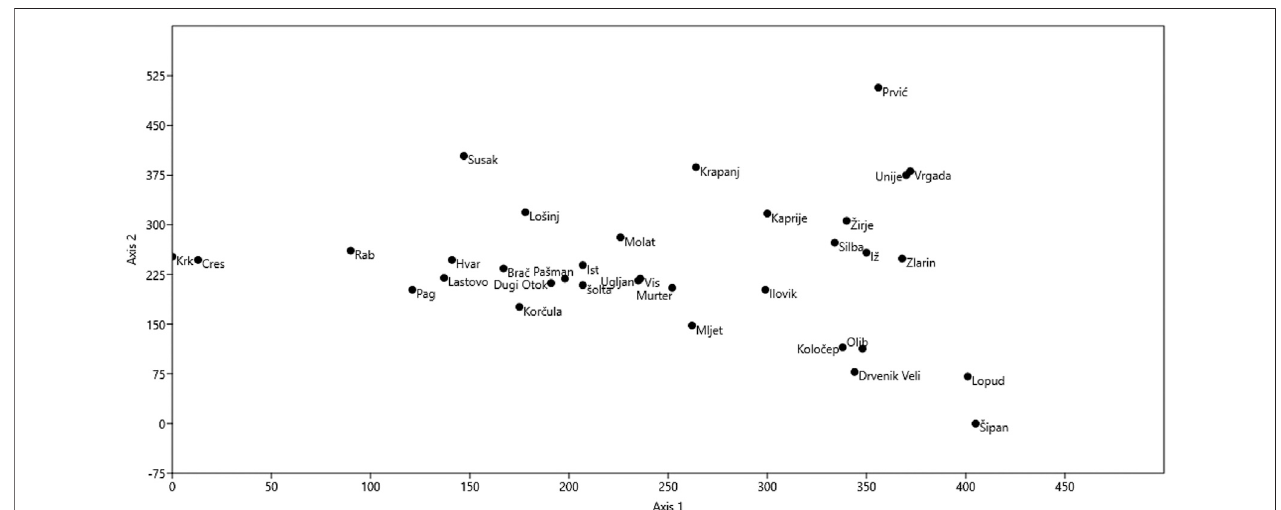
FIGURE 4 | Detrended Correspondence Analysis biplot illustrating the two main axes of variability in the medicinal plant lists used in the studied islands.